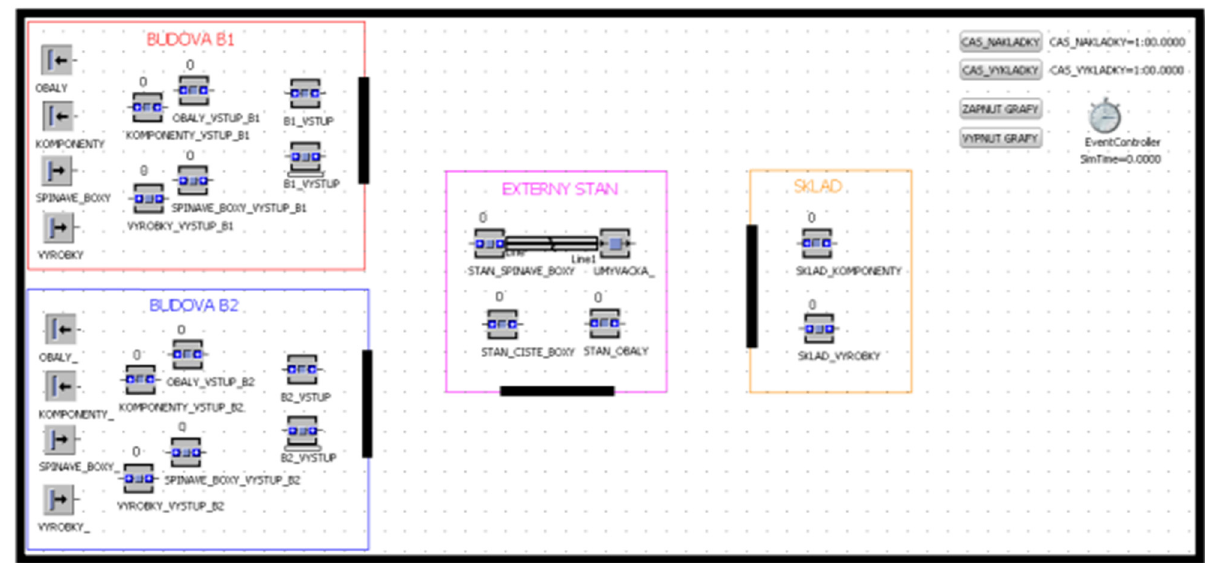
Figure 11: Part of the simulation model used in the case